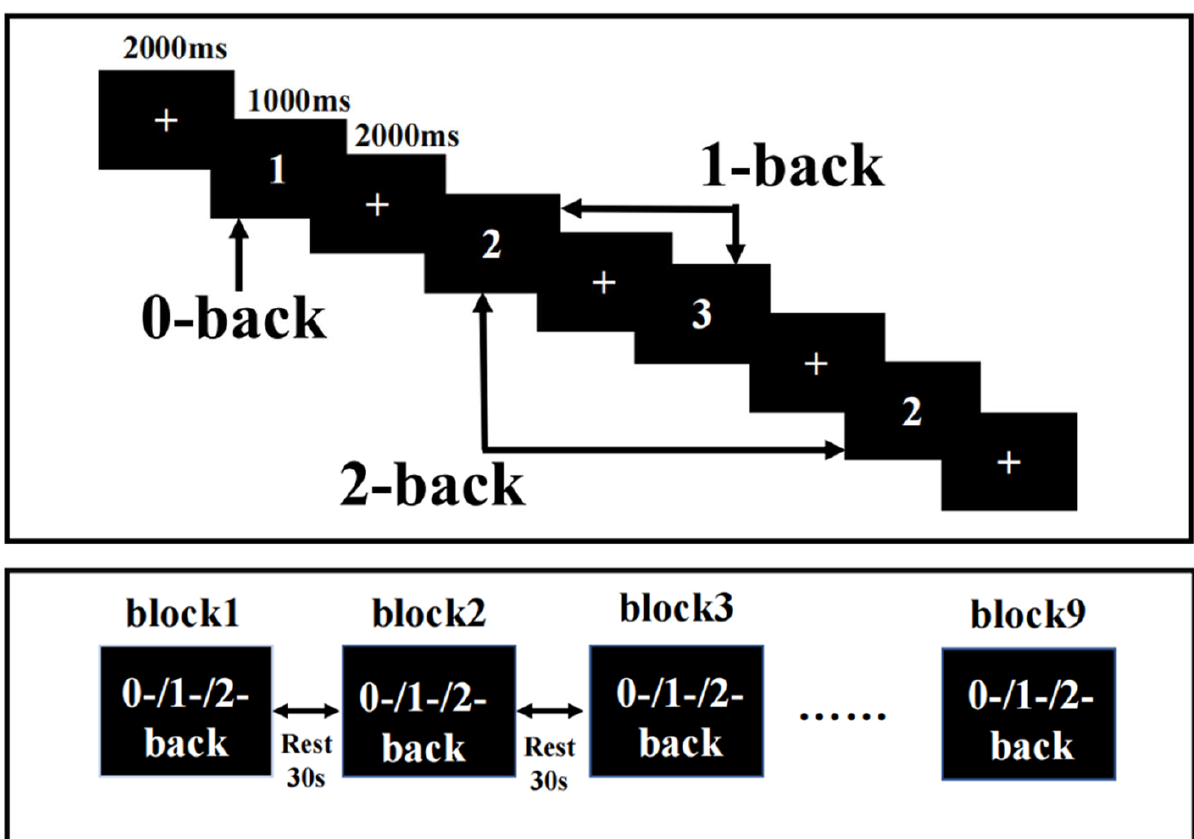
Figure 1. Task design. N-back task with three loads: 0-back, 1-back, and 2-back. A response was required whenever the current stimulus matched the number 1 and the stimulus one or two positions back in the sequence.